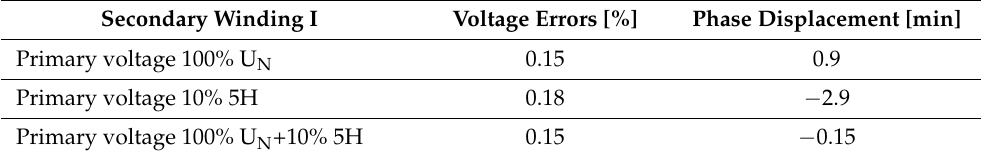
Table 4. Result of voltage errors and phase displacement of the tested VT at different voltage and load 2 M Ω